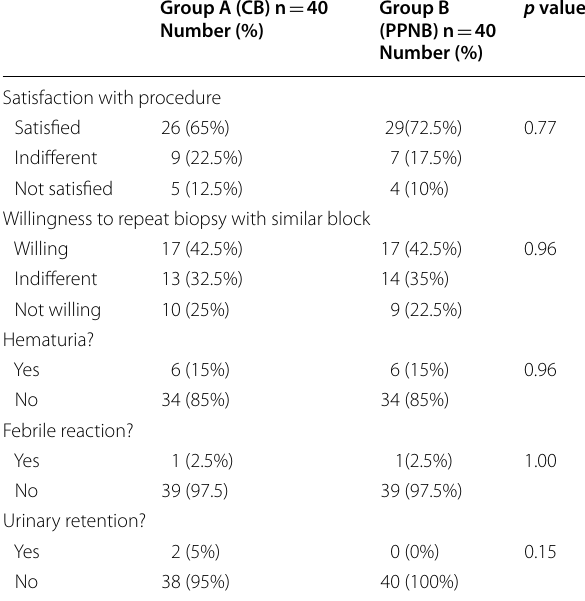
Table 3 Comparison of the proportion of patients who were satisfied with and who were willing to have repeat prostate biopsy using the same method of analgesia between the two groups, and the incidence of complications following prostate biopsy between